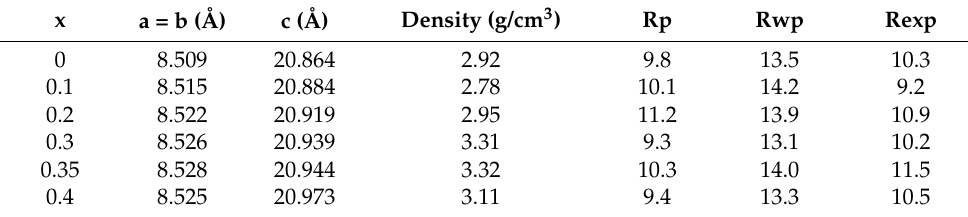
Table 1. Lattice parameters of LATP-xSn (x = 0–0.4) solid electrolytes.